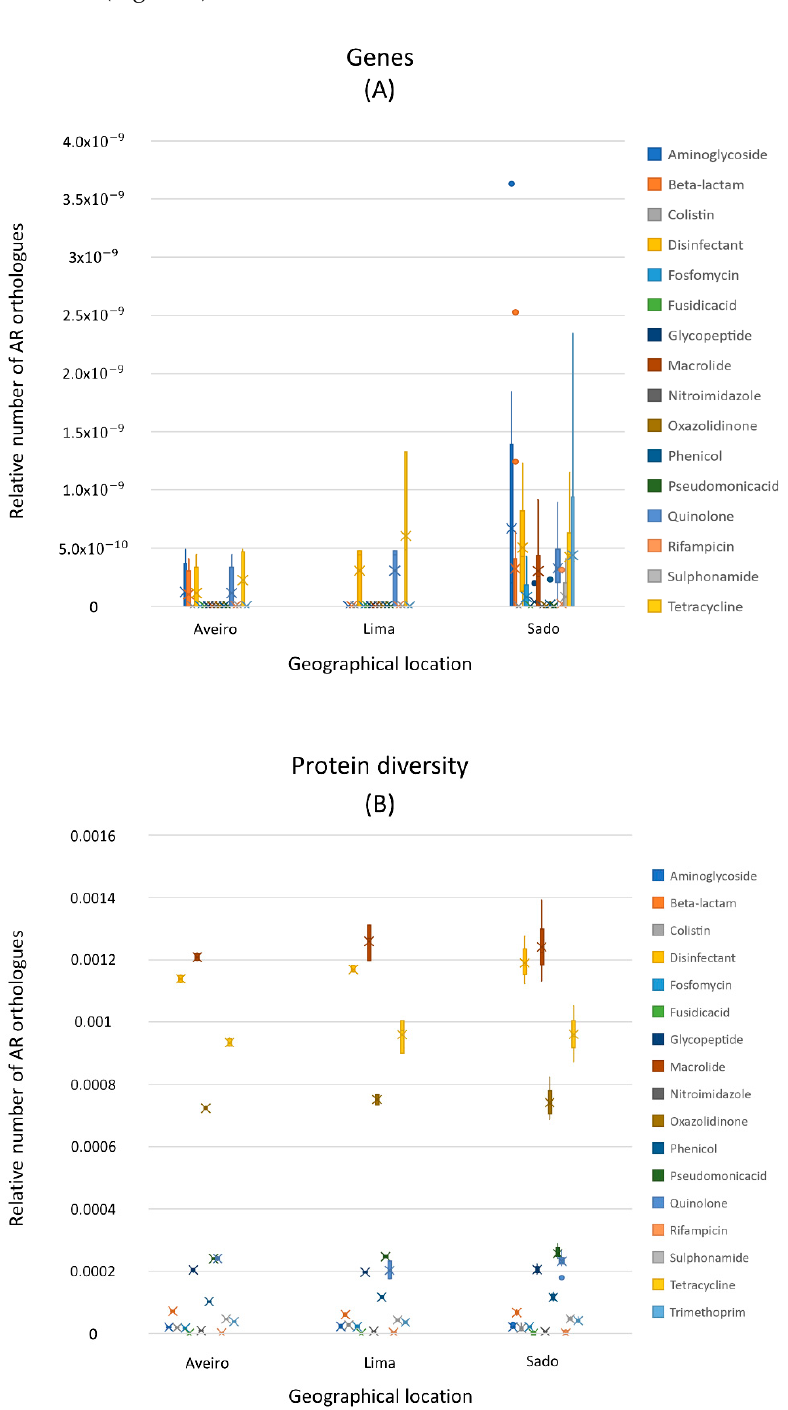
Figure 3. Frequency of different AR groups by antibiotic class according to the ResFinder database and by the geographical location of the river or estuary from which they originate: Sado, Aveiro, and Lima: ( A ) relative number of antibiotic resistance-encoding genes; ( B ) relative number of antibiotic resistance protein diversity. Each box plot represents the distribution of values: the bottom and top of the box are the first and third quartiles, the crosses are the medians, and the vertical lines are the 1.5 interquartile range.